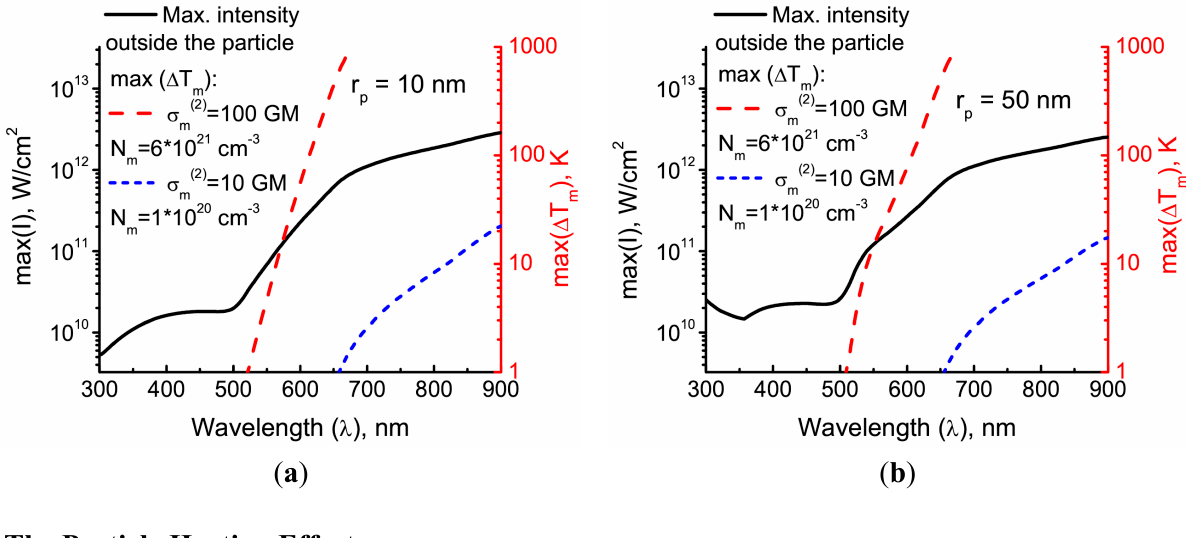
Figure 4. The maximum temperature rise (dashed lines, right axis) and maximum field intensity (black solid lines, left axis) outside the particle reached when the temperature of the particle is raised by 100 K due to irradiation by a circularly-polarized single laser pulse of duration τ pulse = 100 fs. The particle radius is either 10 nm ( a ) or 50 nm ( b ). The volume-specific heat values for the particle and the matrix are C p ρ p = 2.5 J·cm − 3 K − 1 and C m ρ m = 1.7 J·cm − 3 K − 1 , respectively. The dependencies of n p (λ) and n m (λ) for gold and PMMA are taken from [15,16], respectively. The quantum yield η T =